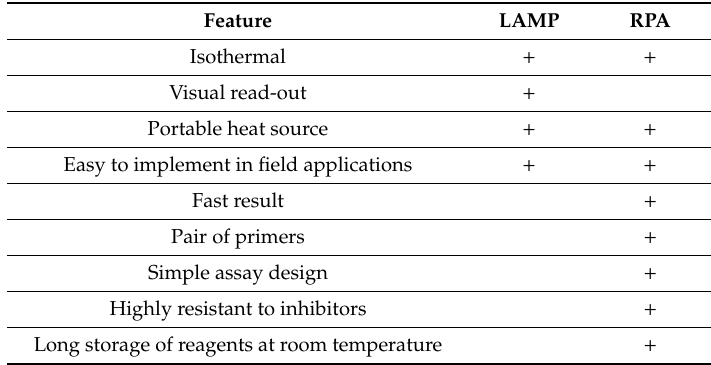
Table 4. Features of Loop-Mediated Isothermal Amplification (LAMP) and Recombinase Polymerase Amplification